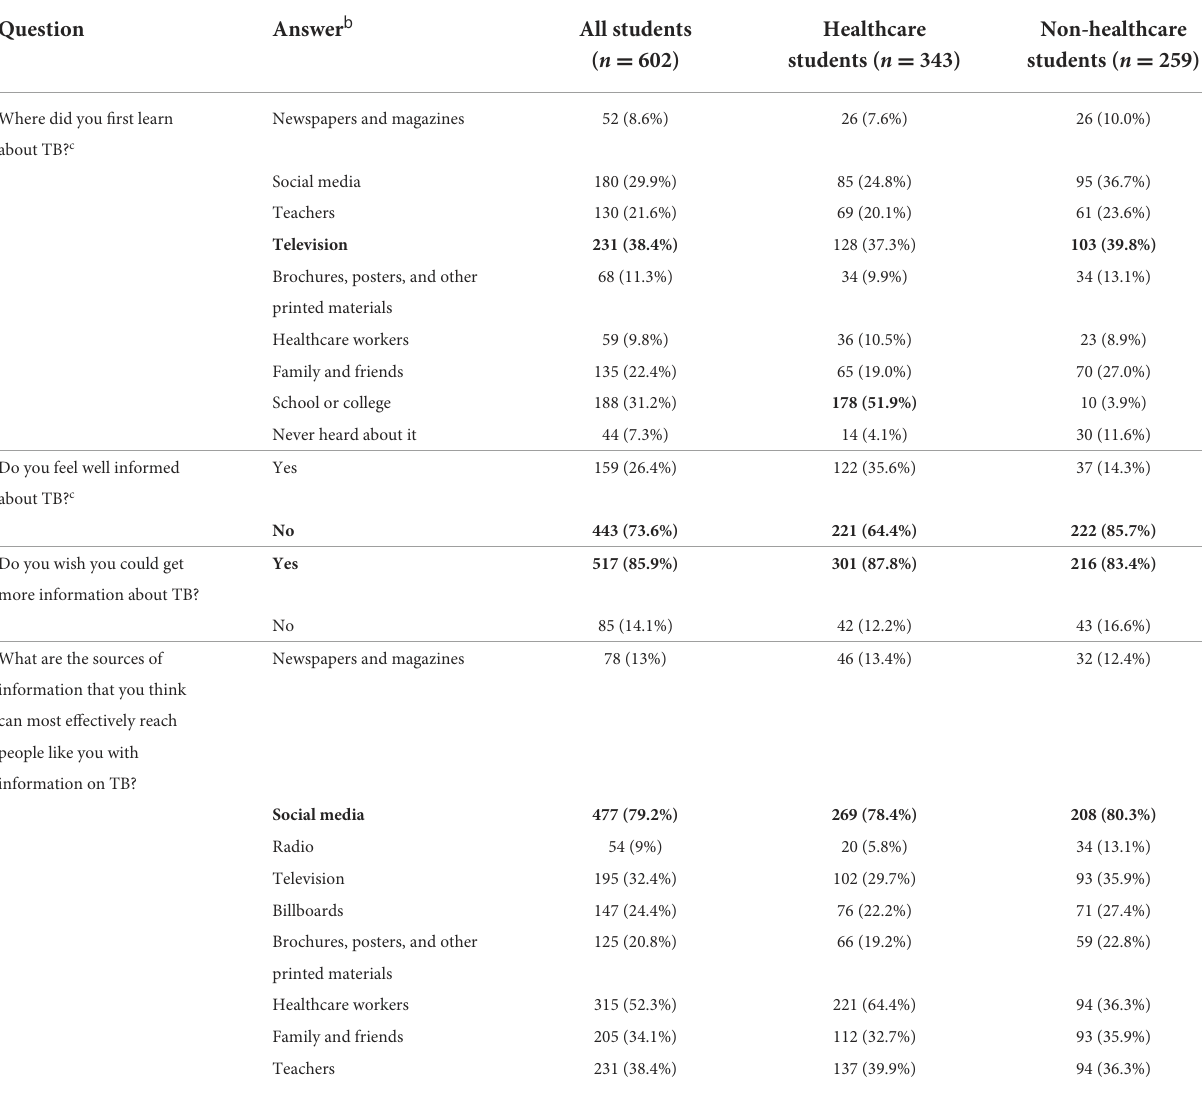
TABLE 7 Sources of information used to learn about TB a